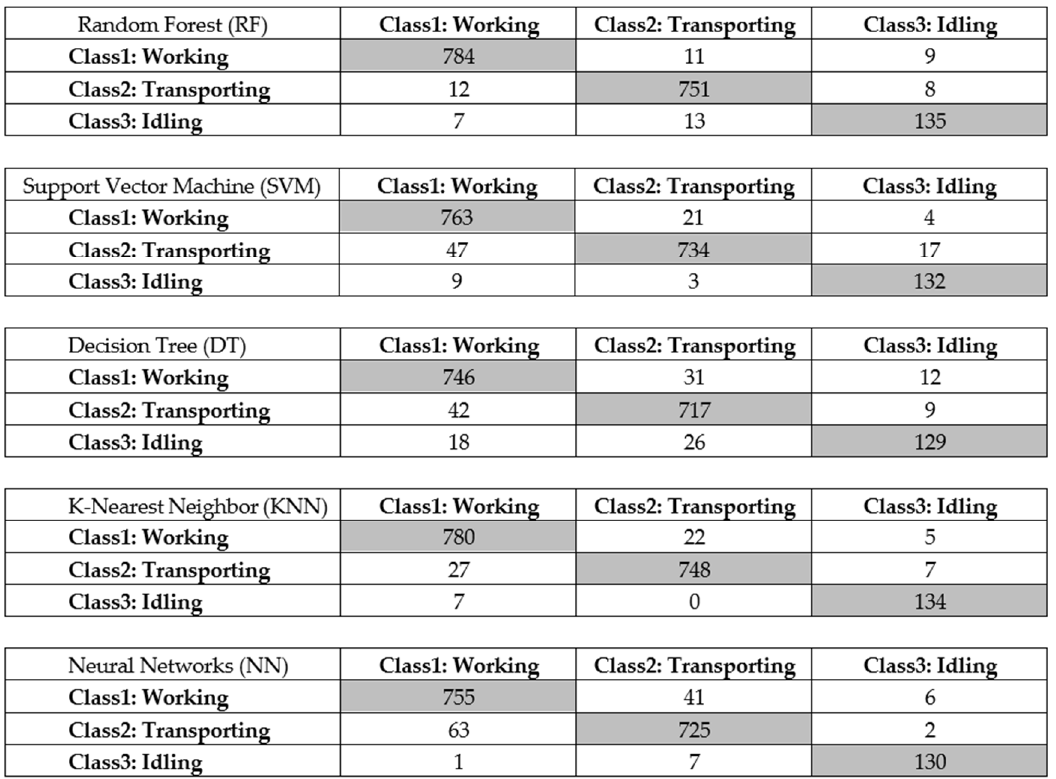
Table 2. The performance of the classifiers.